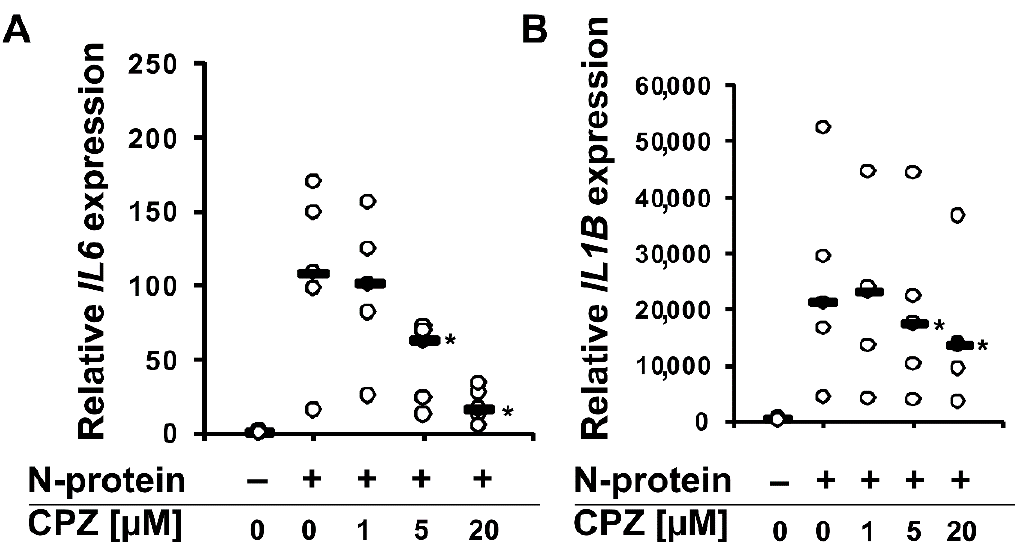
Figure 2. Chlorpromazine inhibits SARS-CoV-2 nucleocapsid-mediated induction of IL-6 protein expression in human monocytes isolated from healthy donors. Monocytes were pretreated with chlorpromazine (20 μ M) for 3 h, treated with mock or SARS-CoV-2 nucleocapsid (1 μ g/mL) for 2 h, stained with IL-6-PE or isotype control antibody and analyzed using flow cytometry. ( A ) Data (fluorescence intensity) are shown as dot plots from five donors (n = 5). Asterisks indicate a statistically significant difference at p < 0.05. Statistical analysis was performed using Friedman Repeated Measures ANOVA on Ranks followed by Student-Newman–Keuls post hoc test. ( B ) Representative histogram of intracellular IL-6.